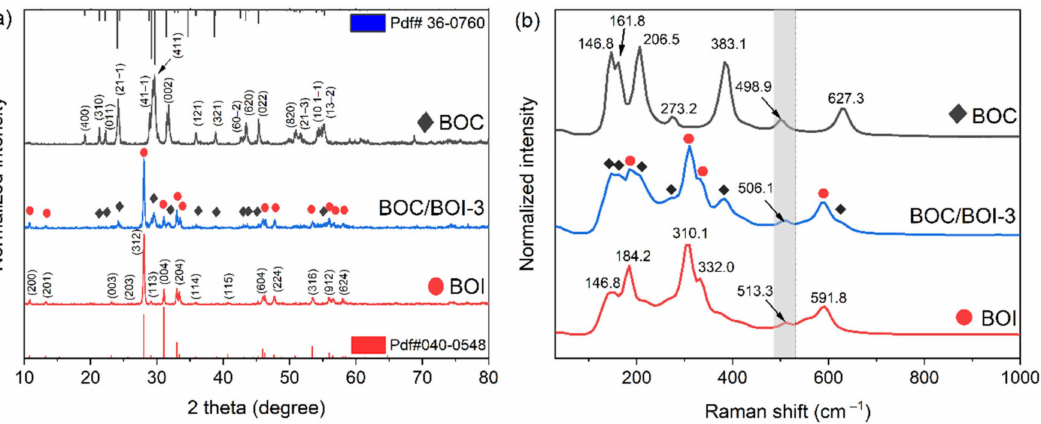
Figure 1. ( a ) XRD patterns and ( b ) Raman spectra of BOC, BOI, and BOC/BOI-3 heterostructure